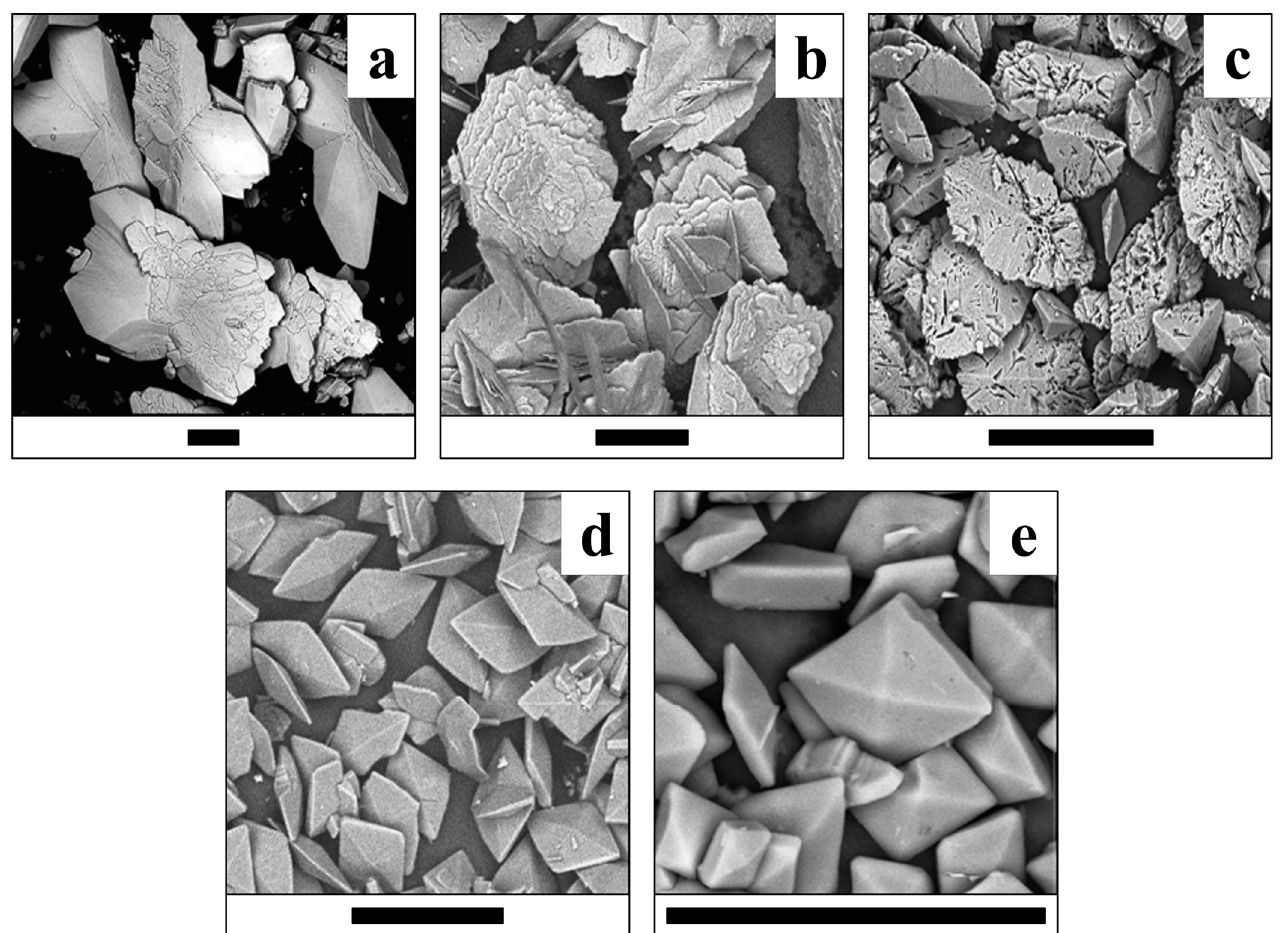
Figure 12. Crystals of (Mg,Mn) C 2 O 4 ∙ 2H 2 O solid solutions (NC series) obtained at various Mg/(Mg + Mn) ratios in solution. ( a )—0%; ( b )—30%; ( c )—60%; ( d )—80%; ( e )—100%. Black bar is 100 μ m.